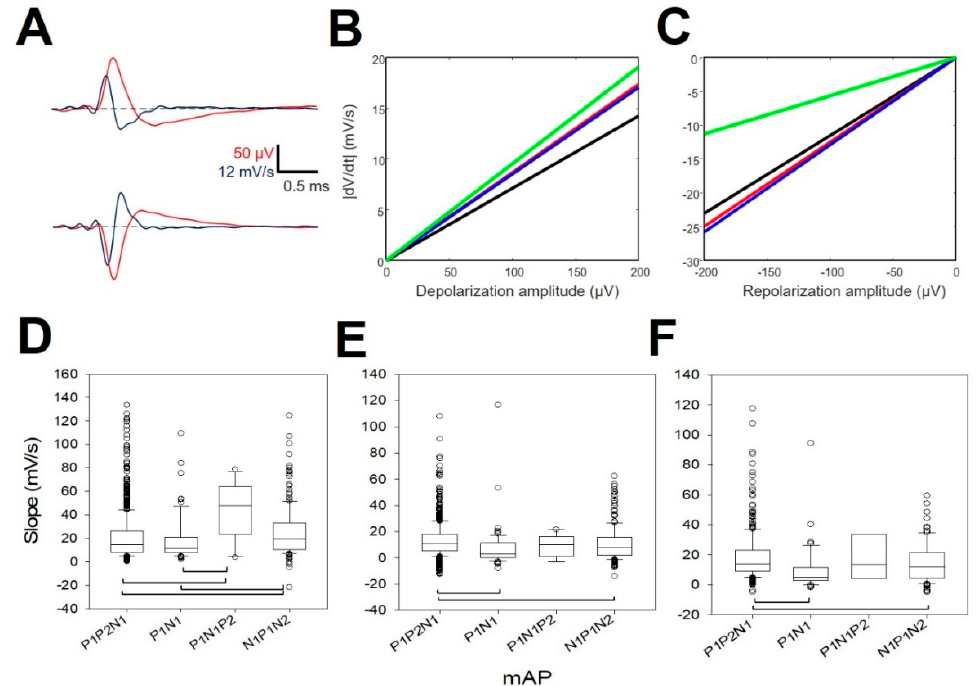
Figure 5. Properties of the first derivative. Relationships between voltage amplitudes and derivatives. ( A ) Examples of negative APs (upper row) and positive (lower row) APs (red) and their derivatives (blue). The maximum value of the | dV / dt | correspond to depolarization in both cases. ( B ) Linear regression between amplitude and dV / dt for repolarization and ( C ) depolarization. P1P2N1 = black; P1N1 = red; N1P1N2 = blue and P1N1P2 = green. Box-plots showing the values of slopes for the three types of negative mAPs. ( D ) First phase slope ( m1 ), ( E ) second phase slope ( m2 ), and ( F ) third phase slope ( m3 ). The horizontal brackets indicate the significant difference with post hoc test between pairs of variables (Kruskal–Wallis One Way Analysis of Variance on Ranks, Dunn’s test post-hoc).